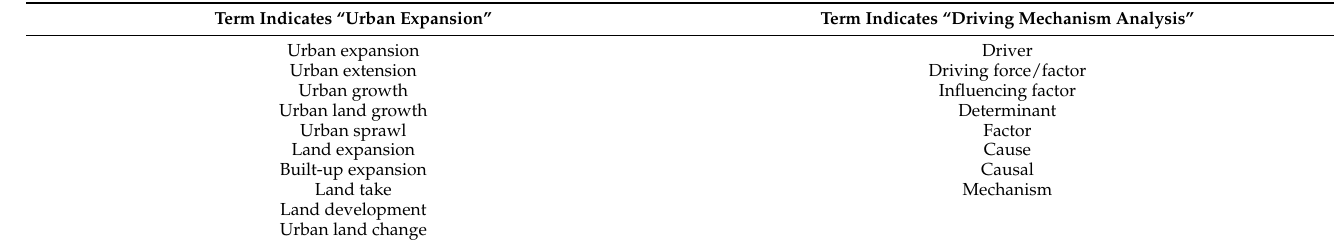
Table A1. Two groups of terms used in search of DAUE